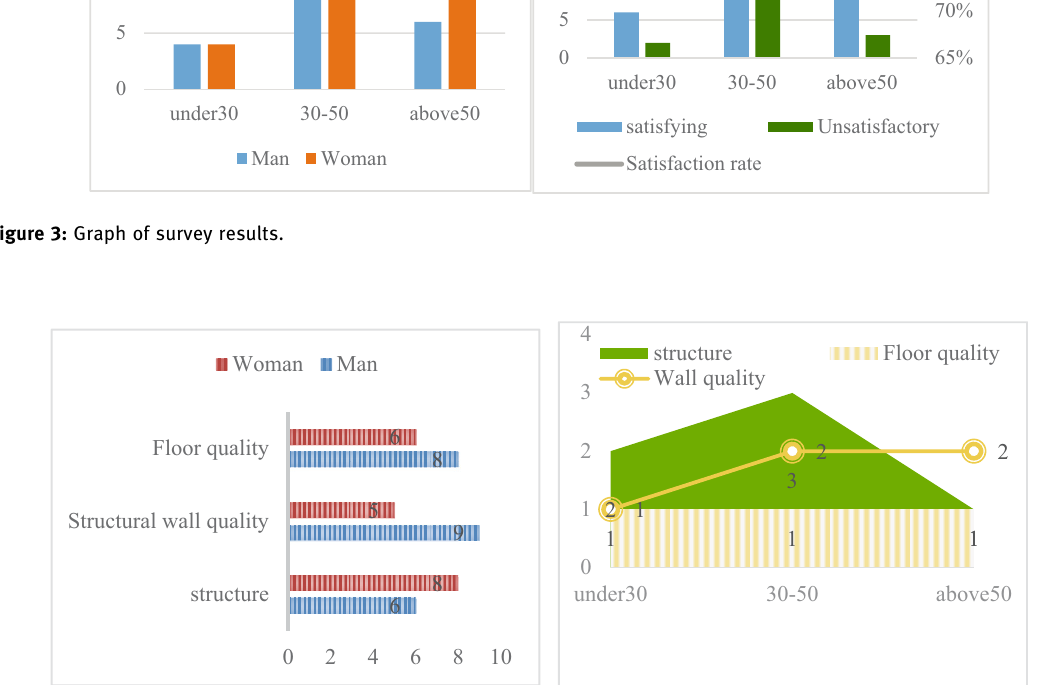
Figure 4: Graph of statistical